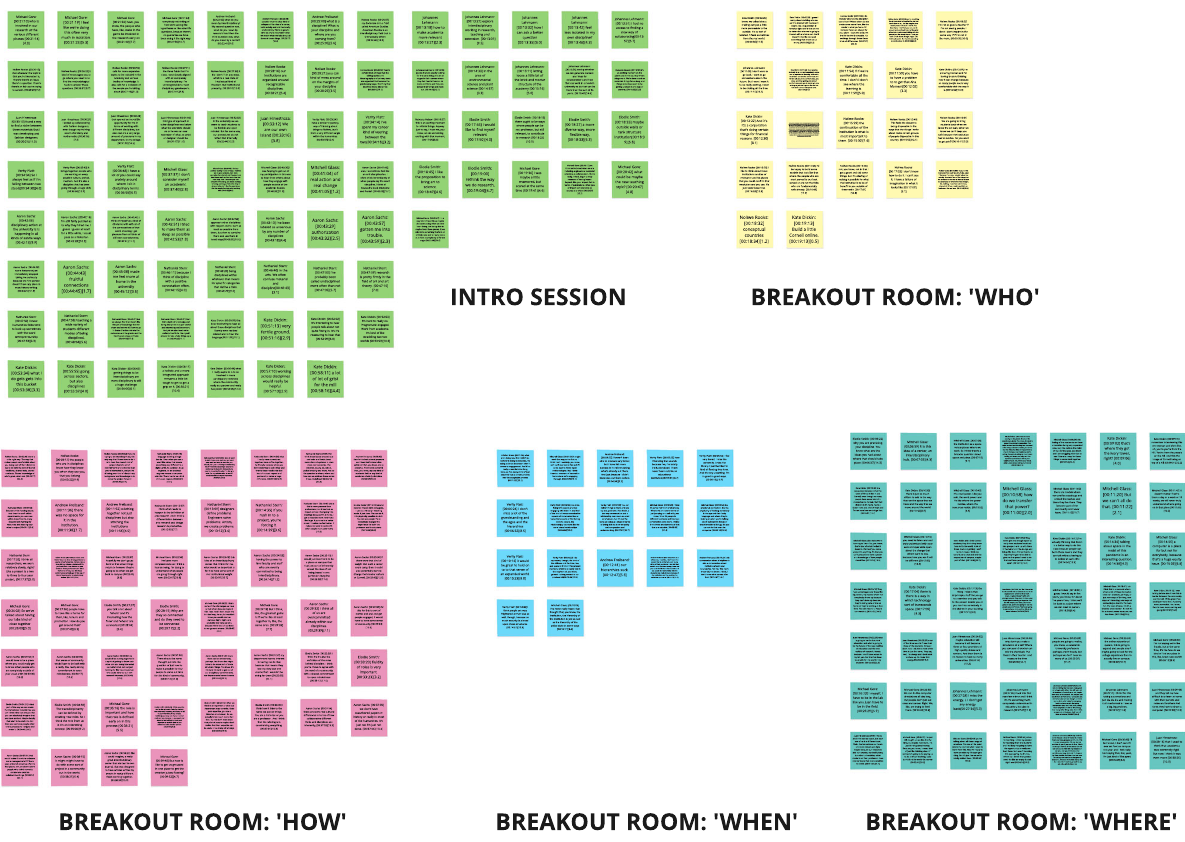
Fig. 3 Conversation analysis overview. Colored squares represented selected statements from the charrette participants. Colors indicate which ‘ breakout ’ conversation the statements came from, therefore visualizing how ‘ on- ’ or ‘ off-topic ’ the conversations were kept (method described in Fig.